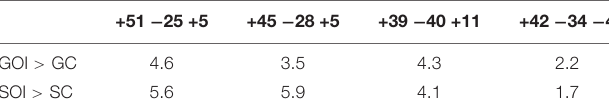
TABLE 6 | Enhanced right temporal lobe activation for object naming > auditory semantic